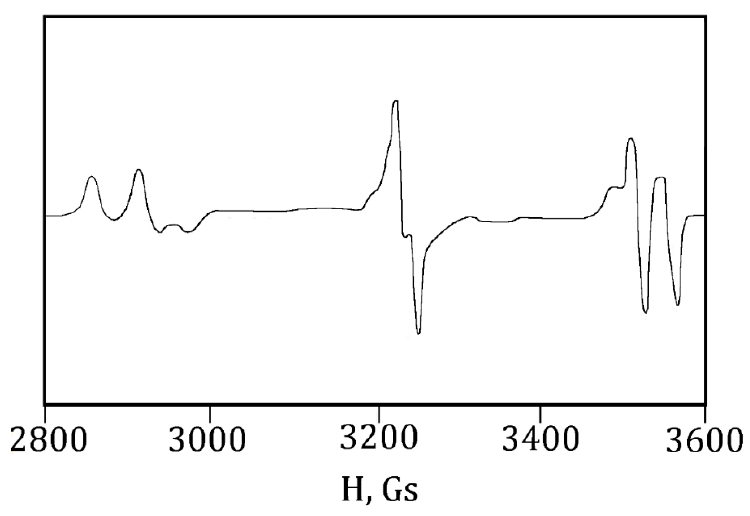
Figure 3. ESR spectrum of sample of the Ag ÷ CCl 4 ÷ 4-cyano-4 ′ -pentylbiphenyl (1:1:100 mol. %) triple system that was obtained during vacuum co-condensation at a temperature 77 K.